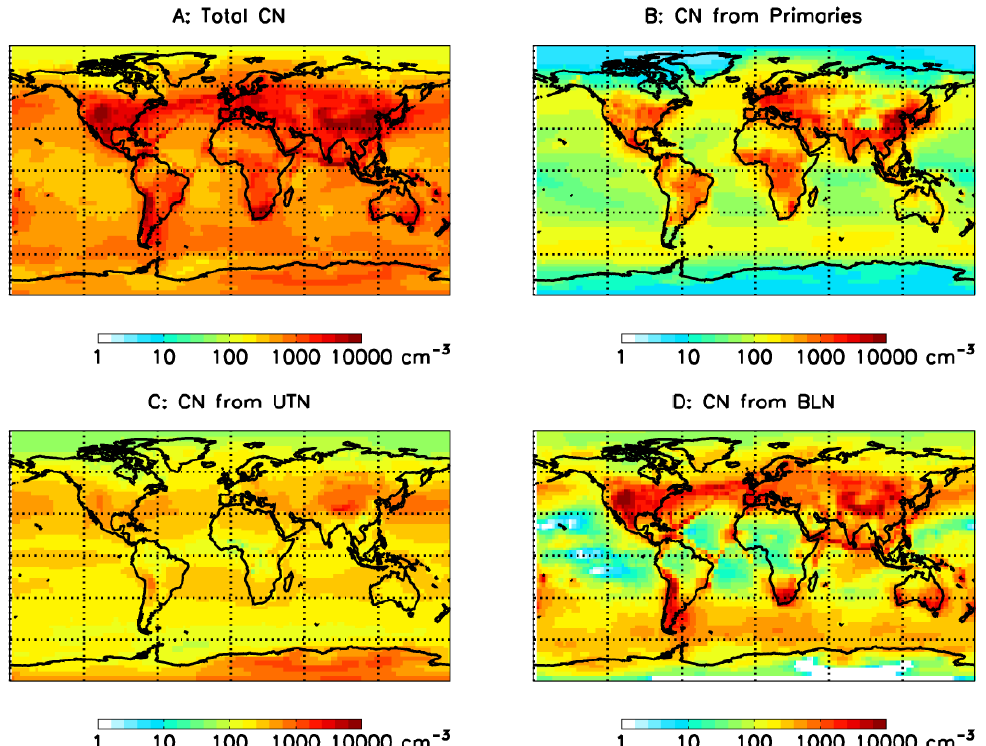
Fig. 12. Ground level total particle (above 3nm in diameter) average concentrations of (a) all particles (sum of panels b , c and d ); (b) primary particles; (c) nucleated particles entrained from upper troposphere; (d) particles nucleated in the boundary layer, as predicted with GLOMAP (published in Merikanto et al.,